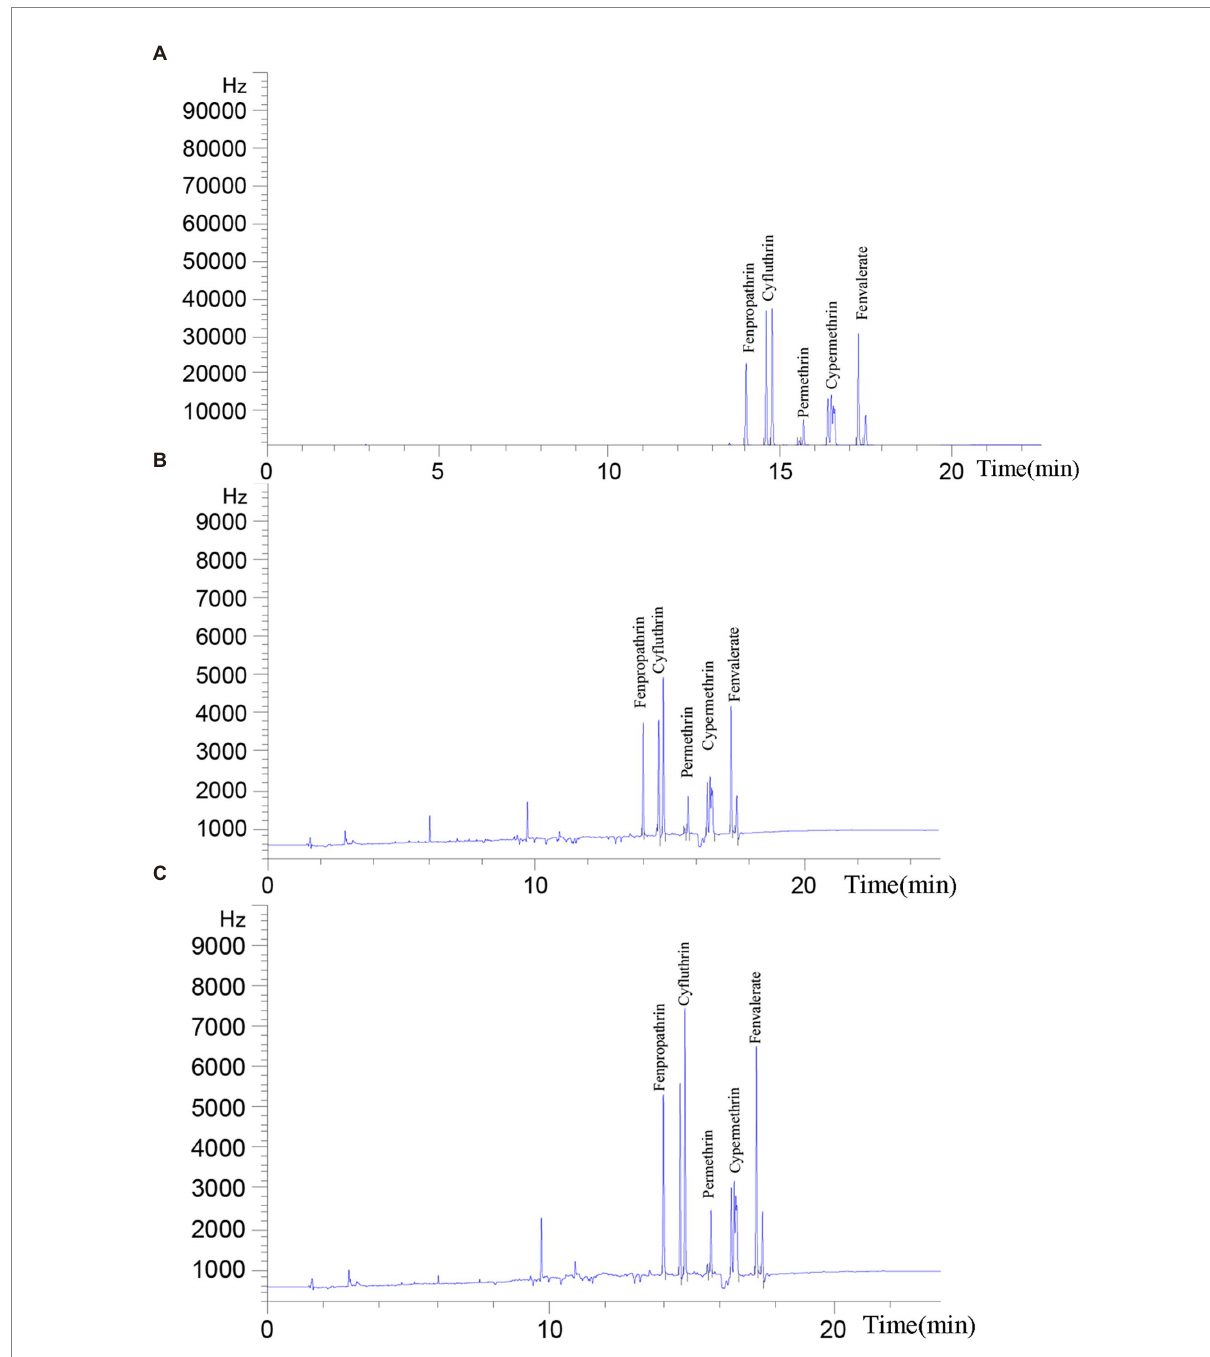
FIGURE 10 Degradation of pyrethroids by purified Est882. The reaction proceeded at 37 ° C for 30 min, and a pyrethroid solution containing inactivated Est882 was used as a control (A) Ultimate pyrethroid concentrations analyzed by GC after incubation with (B) free Est882 and (C) immobilized Est882 for 30 min at 37 °